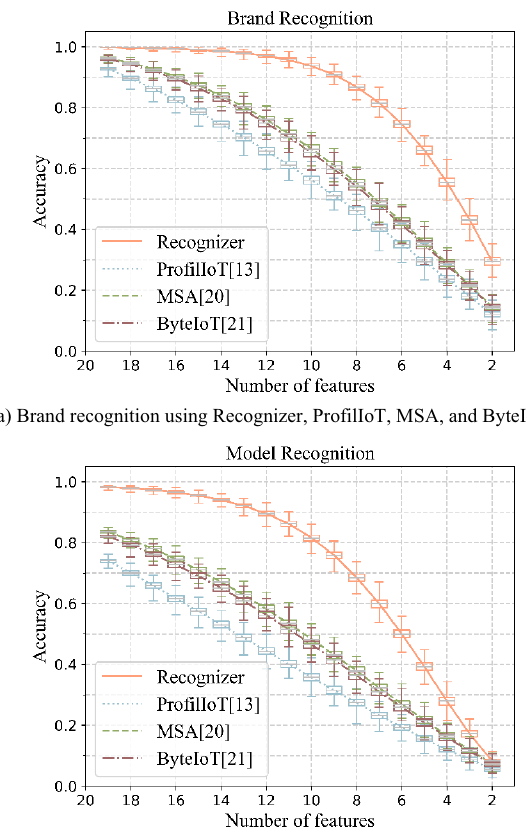
Figure 4. The relationship between recognition accuracy of the four methods and number of features. The box plot shows the maximum, minimum, Q1, Q3, and average of the recognition accuracy of Recognizer, ProfilIoT, MSA, and ByteIoT in 1000 sample sets in each number of